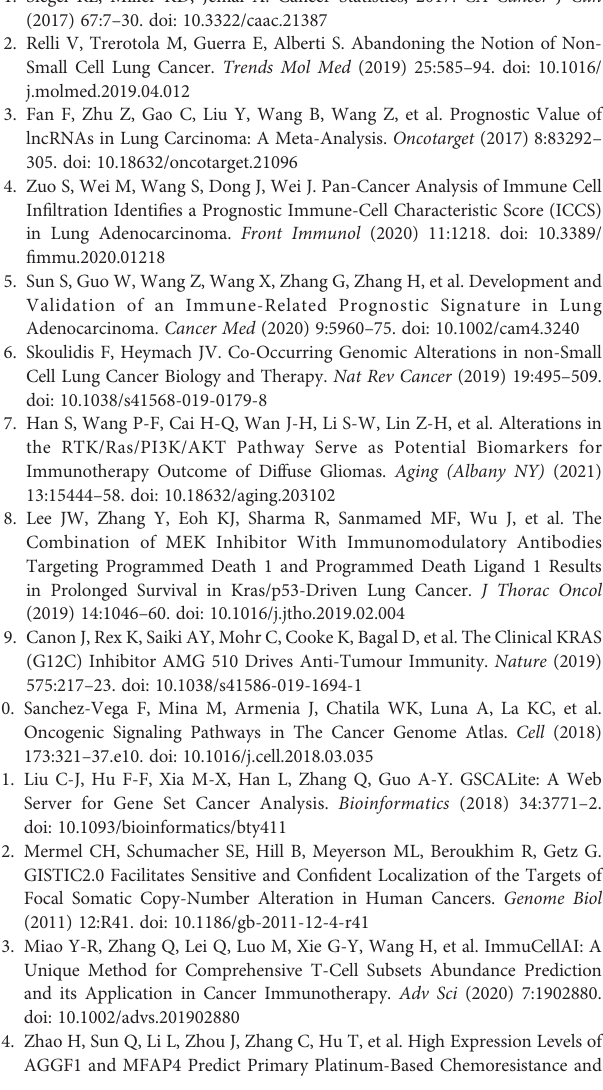
Supplementary Table 10 | 22 RTK/RAS downstream genes. Supplementary Table 11 | The association of SNV, CNV, and methylation with immune cell abundance.